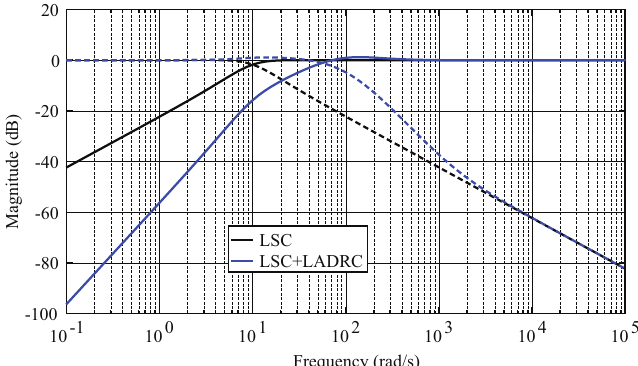
Figure 14. Comparison of the LSC and the LADRC + LSC schemes in terms of noise sensitivity, dashed lines, and input disturbance sensitivity, solid